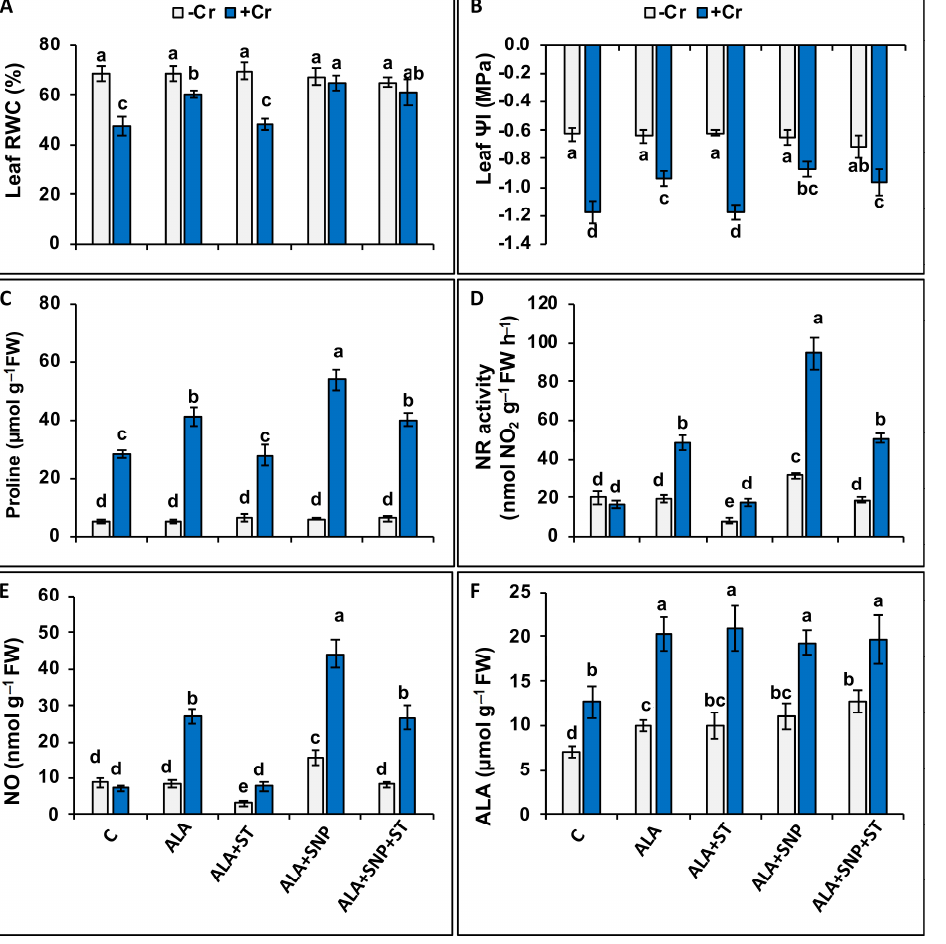
Figure 3. Leaf relative water content (RWC) ( A ), leaf water potential (Leaf Ψ l) ( B ), free proline ( C ), nitrate reductase (NR) activity ( D ), nitric oxide (NO) content ( E ), and 5-aminolevulinic acid (5-ALA) content ( F ) in Cr-treated (+Cr), and non-treated ( − Cr) tomato seedlings, sprayed with 20 mg L − 1 5-aminolevulinic acid (5-ALA), 0.1 mM sodium tungstate (ST) + 5-ALA, 5-ALA + 0.1 mM sodium nitroprusside (SNP), or 5-ALA + SNP + ST. Data are means ± S.E, different lower-case letters on bars reflect that mean values differ significantly at p ≤ 0.05.